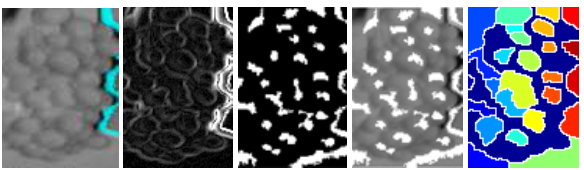
Figure 11: Watershed segmentation results based on the intensity image: Original intensity image, gradient magnitude, regional maxima, regional maxima superimposed on original intensity image and colored watershed label matrix (from left to right).